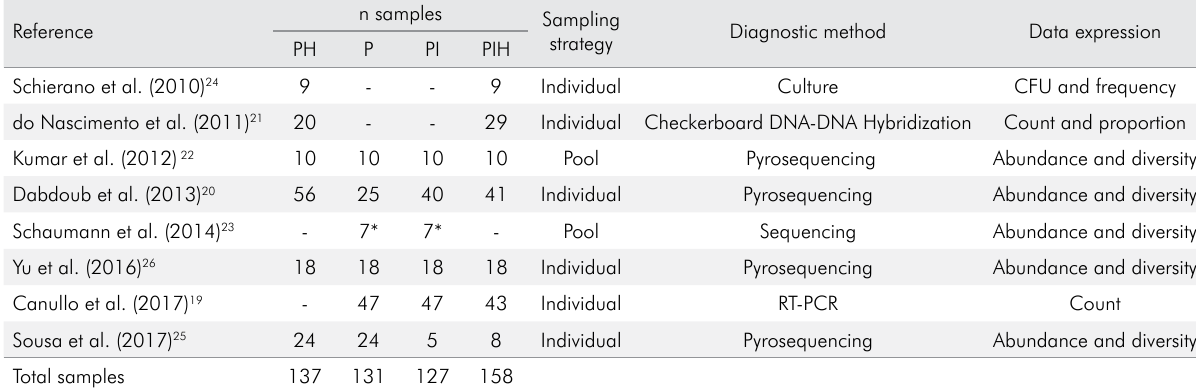
Table 5. Methodological features of sample collection and